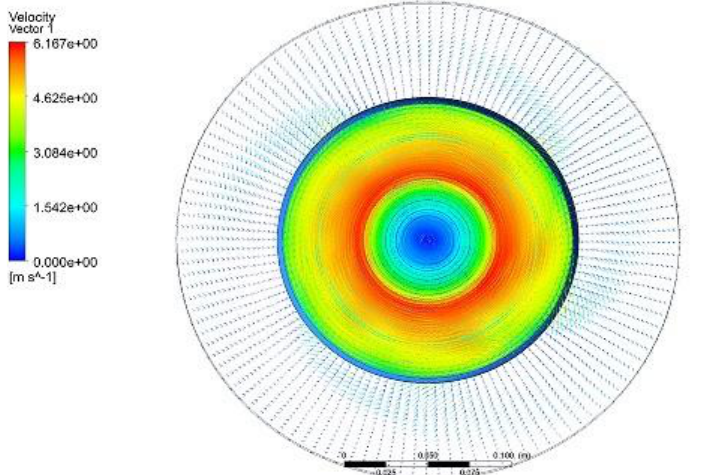
Figure 18. ( δ = 0.6, r = 1000).